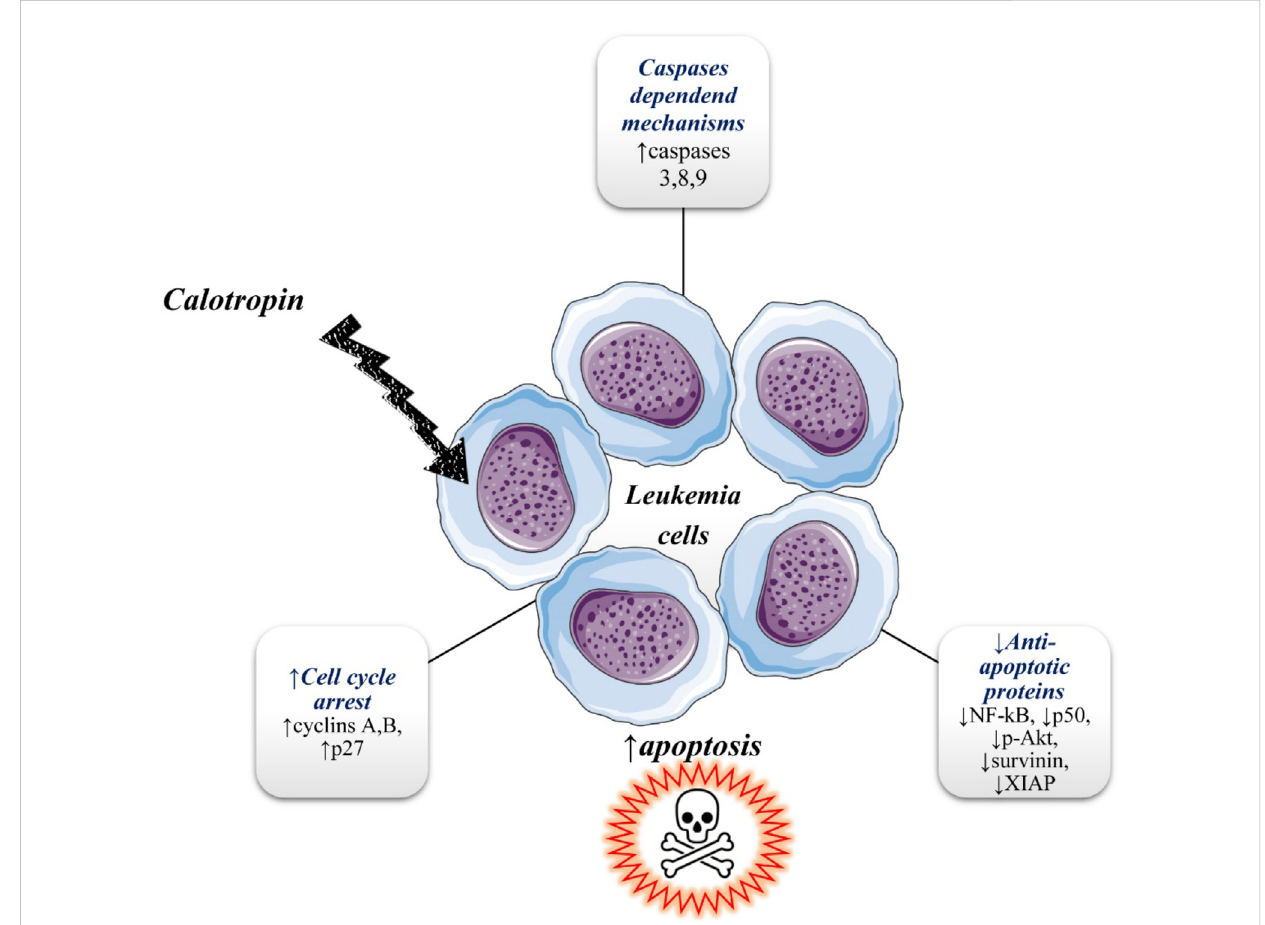
FIGURE 4 Illustrative diagram with anti-leukemic mechanisms of calotropin. Symbols: ↑ increase, ↓ decrease.